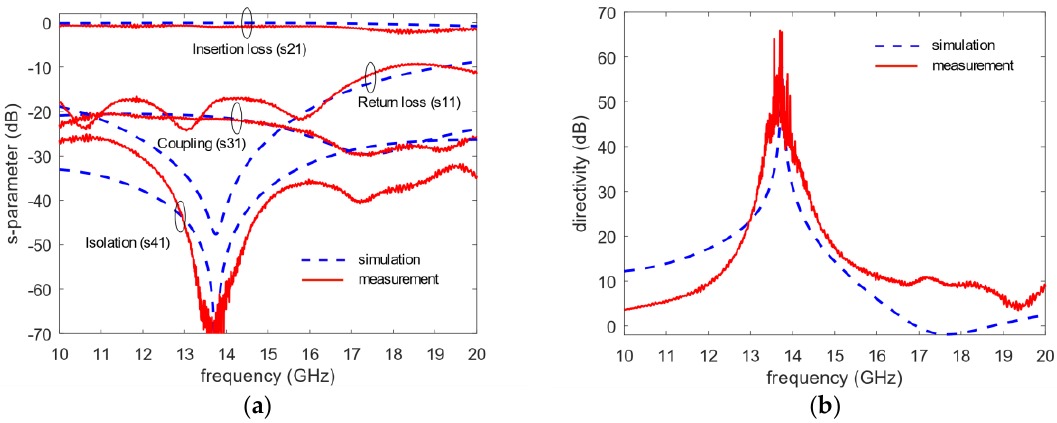
Figure 10. Comparison of the measurement results: ( a ) S-parameter; ( b ) Directivity.